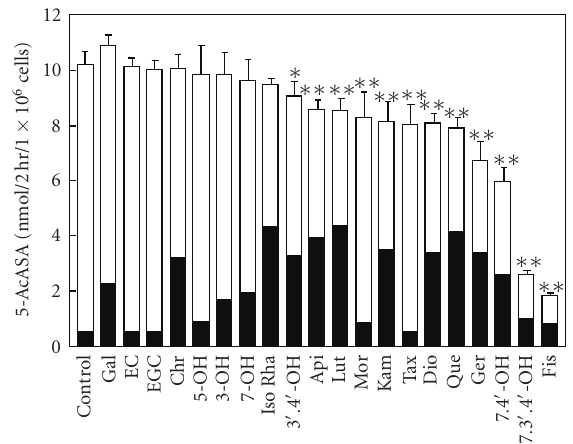
Figure 3: The amount of N -acetyl 5-aminosalicylic acid in Caco-2 cells and the medium. Caco-2 cells grown in tissue culture dishes were incubated with 200 μ M 5-ASA for 2 hours in the presence of flavonoids at the concentration of 100 μ M. 5-ASA in cells (Closed column), 5-ASA in medium (Open column). Each bar represents the mean ± SD of four to five experiments. Significant di ff erence from control ∗ P < . 05, ∗∗ P < .